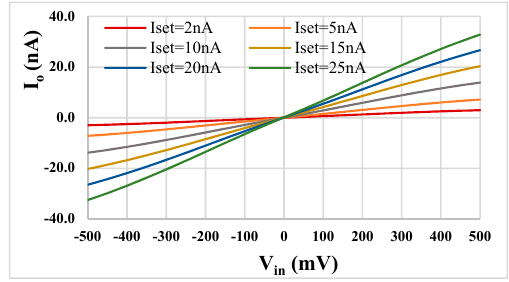
Figure 8. DC transfer characteristic of the MI-G m .